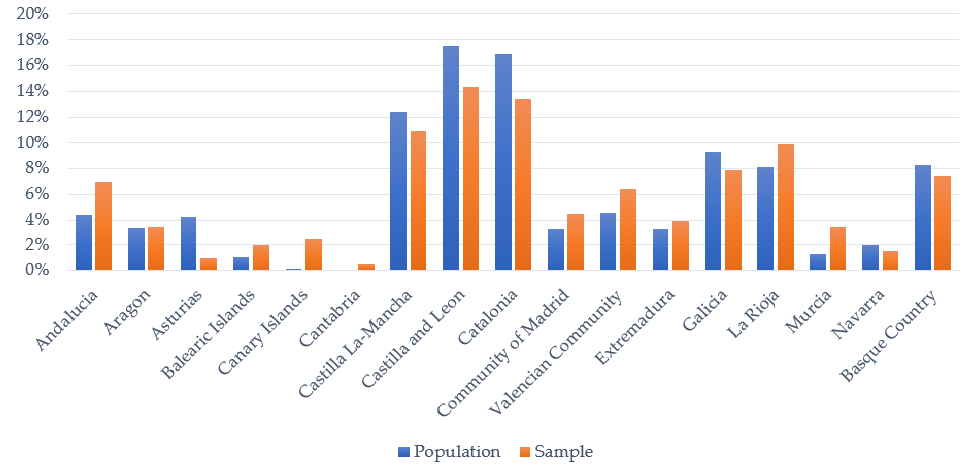
Scheme 2. Geographical distribution of the sample companies and the study population. Source: Authors’ own elaboration.